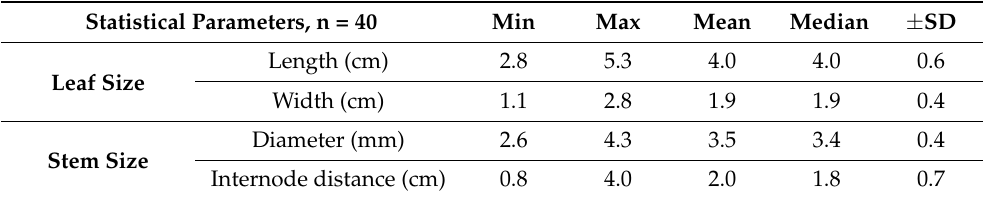
Table 1. H. foliosum leaf and stem dimensions.